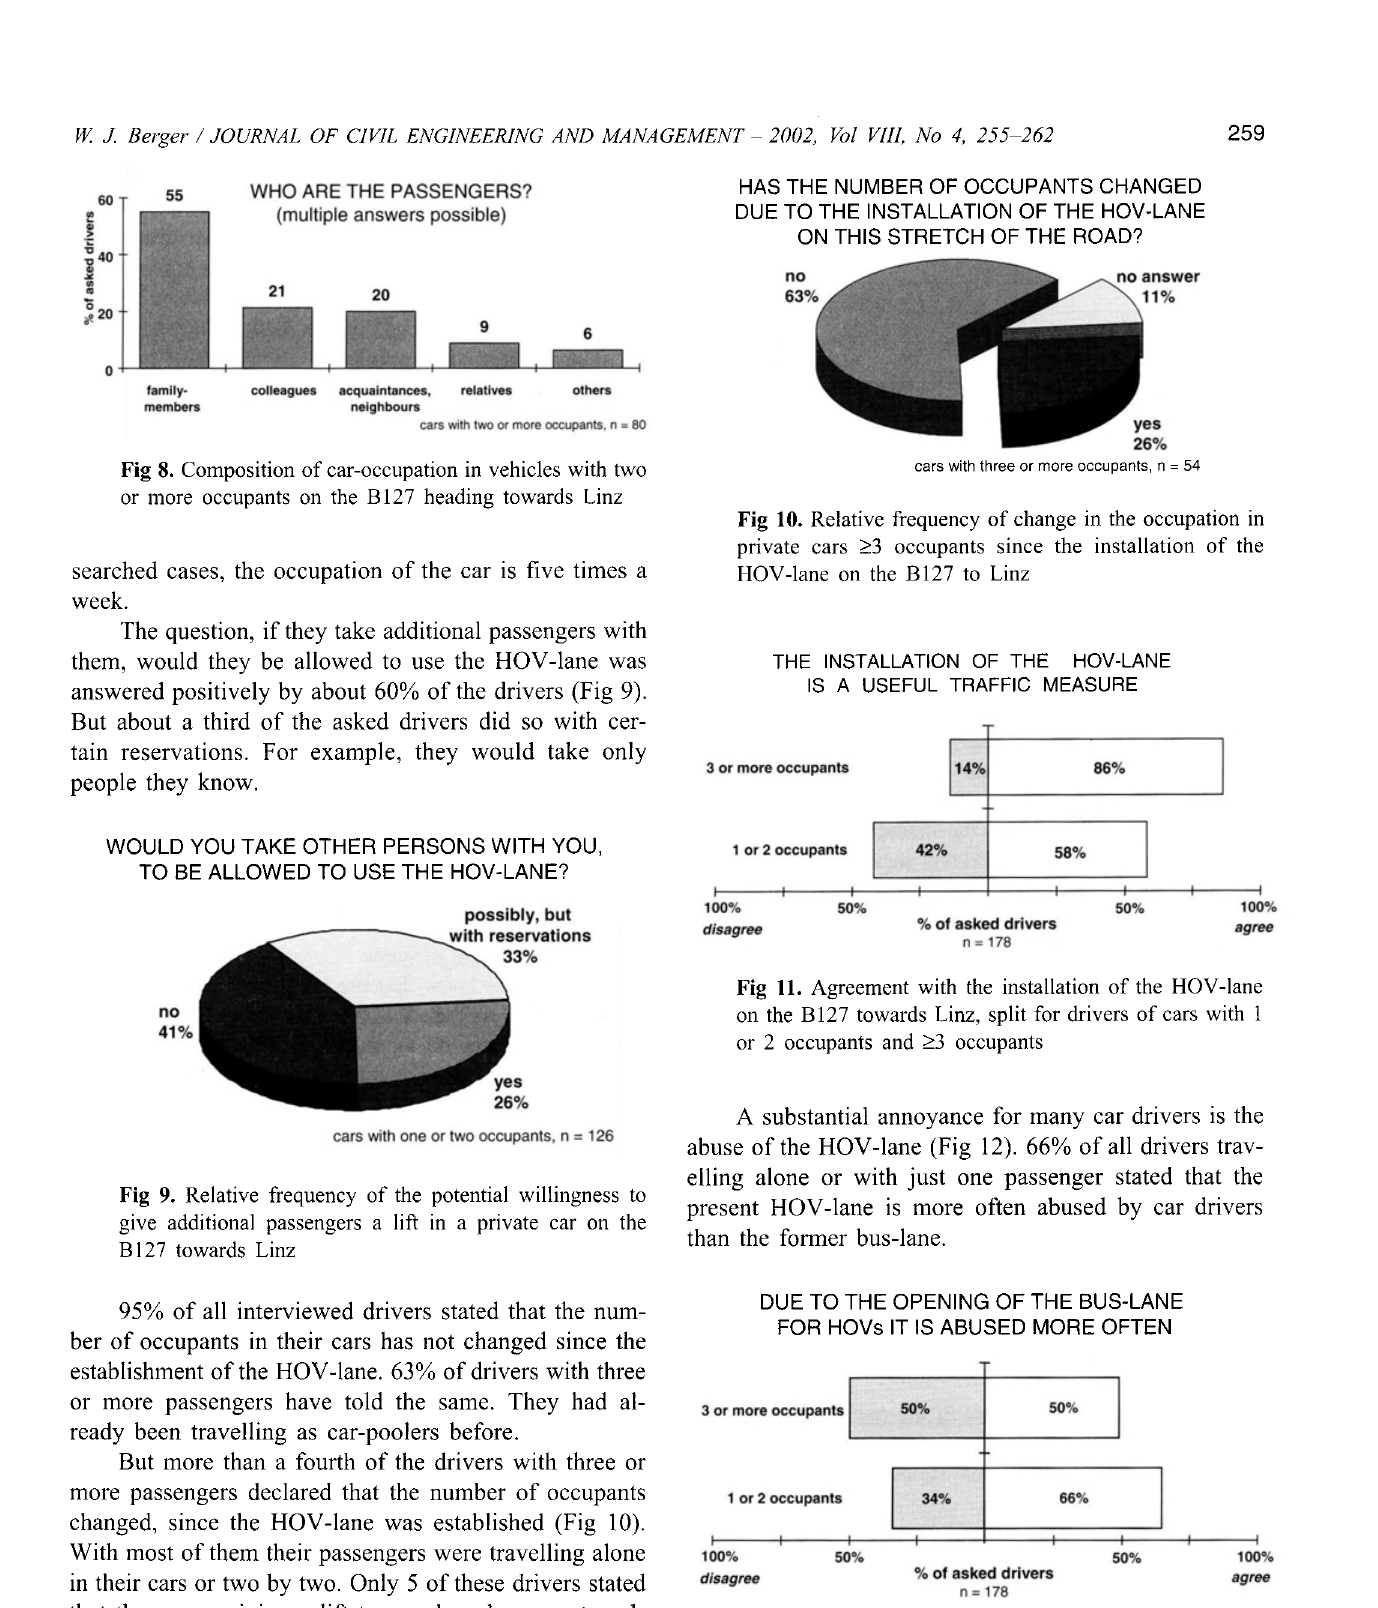
Fig 8. Composition of car-occupation in vehicles with two or more occupants on the B127 heading towards Linz searched cases, the occupation of the car is five times a week.